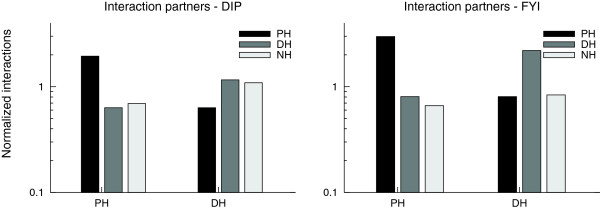
Interaction partners for party hubs (PHs) and date hubs (DHs). The displayed values are normalized fractions of the interactions (Normalized Interactions) that involve party hubs, date hubs or non-hubs for PH and DH, respectively. The values are normalized against the number of interactions that involve the respective protein types in the network. Hence, Normalized Interactions >1 signify that the given interaction pair (for example, PH-PH) is overrepresented compared to other interactions with PH, which is seen both in DIP and FYI.